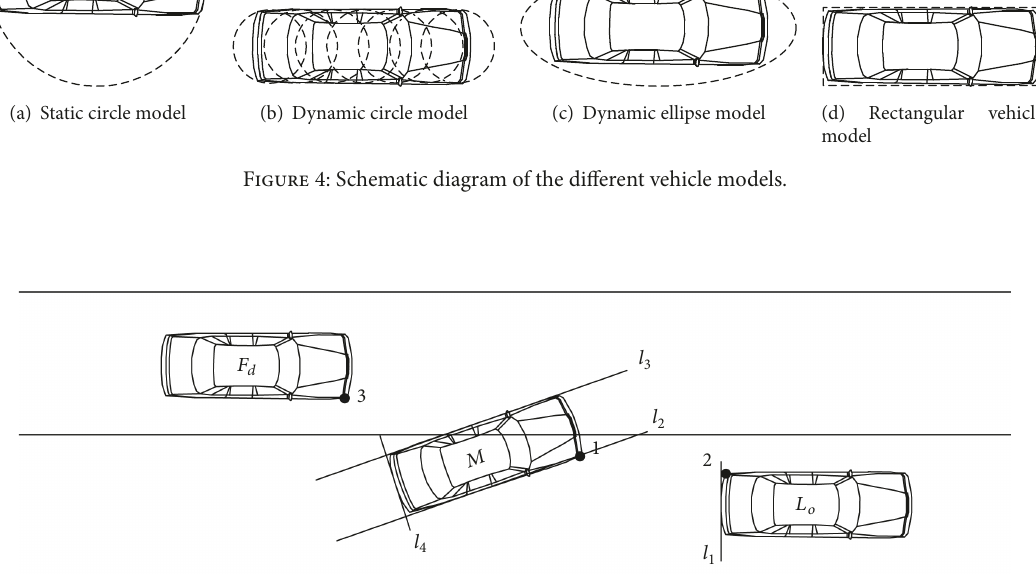
Figure 5: Collision relationships between the vehicles during the accelerated lane-changing